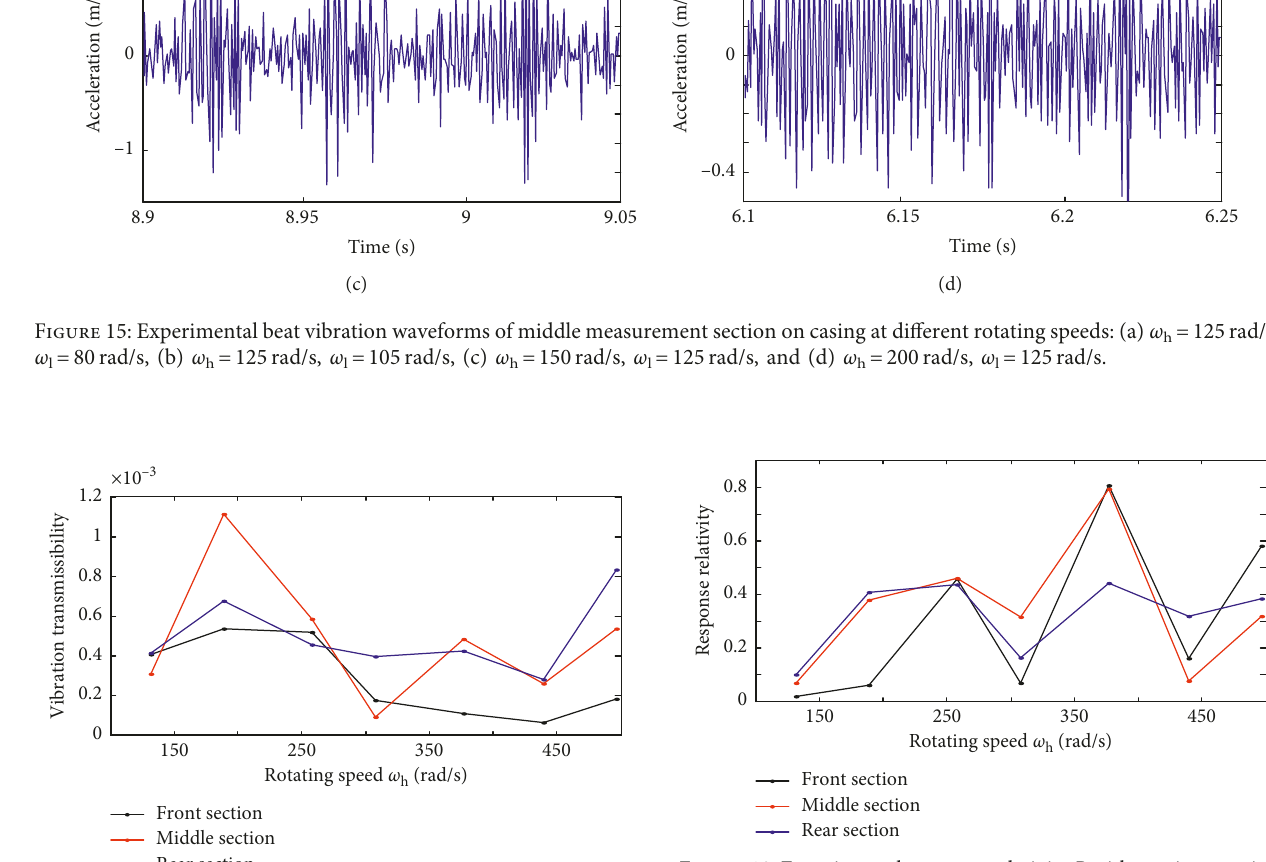
Figure 18: Experimental response relativity R with varying rotating speed of high-pressure rotor ω h : front section (black), middle section (red), and rear section (blue).